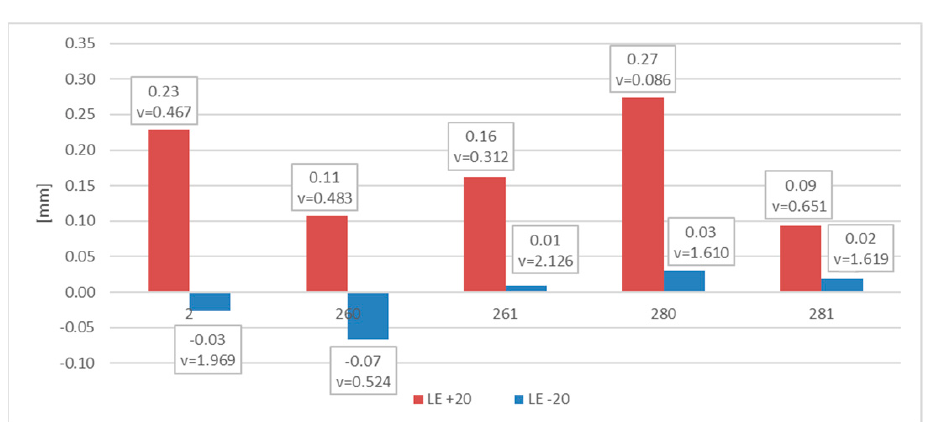
Figure 16. Averaged values of the LE parameter and corresponding coefficients of variation (estimated on a statistical sample) obtained on impact toughness test samples made of X20Cr13 steel.